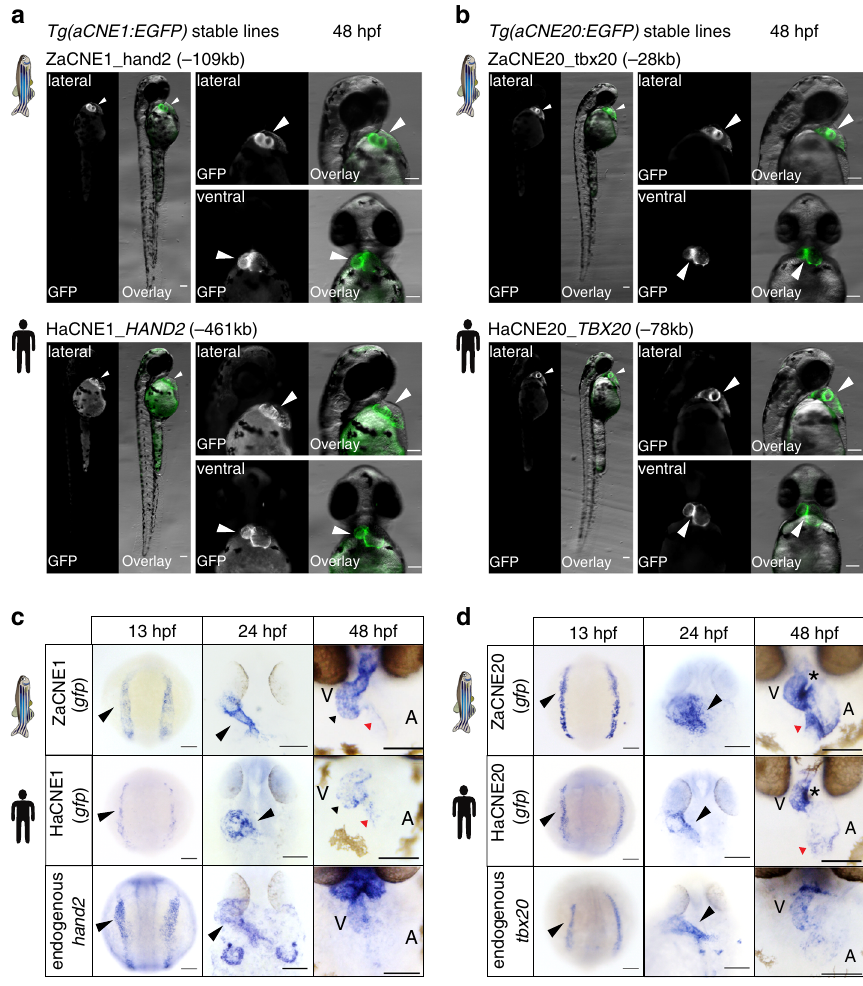
Fig. 4 Anciently conserved open chromatin regions share conserved cardiac activities. Fluorescent images ( a , b ) of aCNE transgenic lines generated using zebra fi sh or human sequences. In-situ characterization ( c , d ) of the activities of the zebra fi sh (upper panel) and human (middle panel) aCNE sequences and the endogenous expression of zebra fi sh cardiac genes (lower panel) nearby. In 48 hpf images in ( c ), black triangles indicate staining in ventricles and red triangles staining in the inner curvature of atria for both aCNE1 transgenic lines. In 48 hpf images in ( d ), stars indicate the conserved activity of both aCNE20 enhancers at the inner curvature of ventricles and atrioventricular canal regions and red triangles point to the staining in in fl ow tract. All images shown were collected from embryos of stable lines and all scale bars represent 100 μ